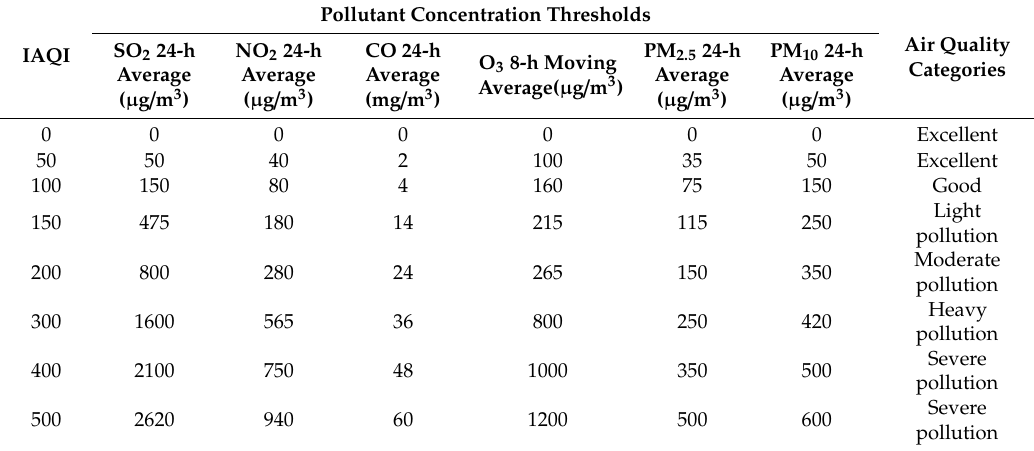
Table 5. Individual air quality index (IAQI), concentration thresholds and air